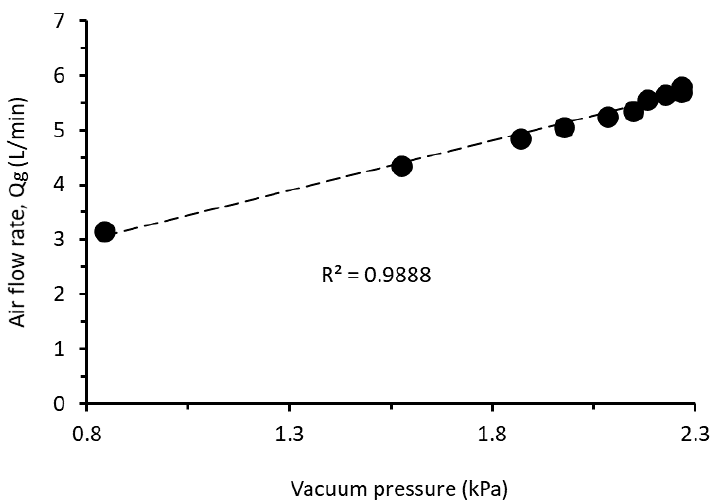
Figure 5. A linear relationship of the air velocity to the vacuum pressure generated by the venturi-orifice microbubble generator.